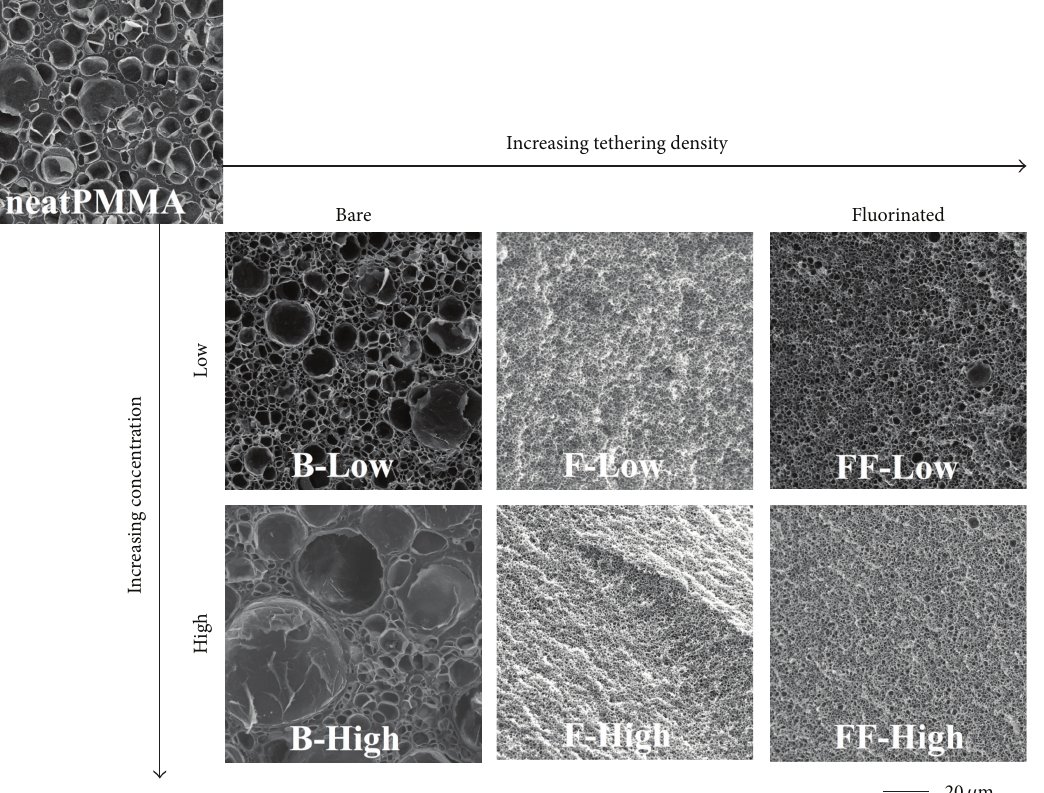
Figure 5: SEM images of the foamed samples with varying surface modification and concentration.